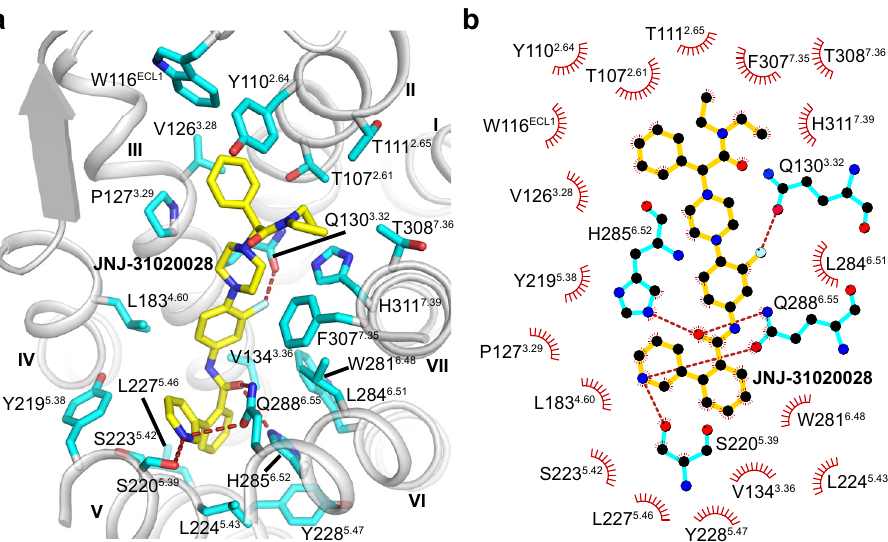
Fig. 2 Binding mode of JNJ-31020028 in Y 2 R. a Ligand-binding pocket for JNJ-31020028. Y 2 R is shown in gray cartoon representation. The Y 2 R residues (carbon in cyan) that form interactions with JNJ-31020028 are shown as sticks. JNJ-31020028 (carbon in yellow) is shown as sticks and hydrogen bonds are shown as red dashed lines. b Schematic representation of interactions between Y 2 R and JNJ-31020028 analyzed using LigPlot + program 47 . The Y 2 R residues engaged in hydrogen bonds are shown as cyan sticks. Hydrogen bonds are shown as red dashed